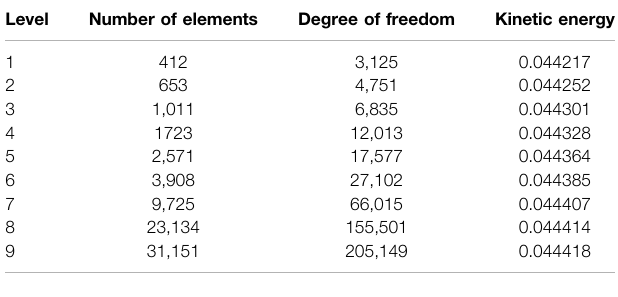
TABLE 1 | Description of the base fl uid and nanoparticles properties.